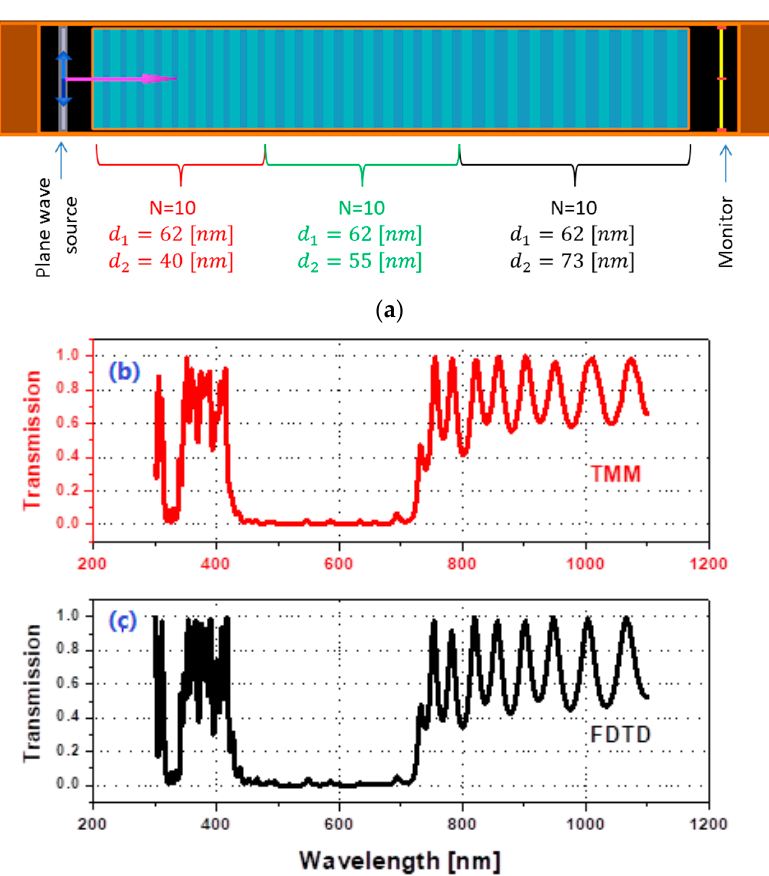
Figure 7. 1D binary photonic crystals of Bi 4 Ge 3 O 12 with thickness 62 nm and μ c-SiO x = :H with 40 nm, 55 nm, and 73 nm; ( a ) Schematic structure of considered the structure, ( b ) Transmission behavior for the structure by MATLAB based on TMM, and ( c ) Transmission behavior for the structure by lumerical based on FDTD.